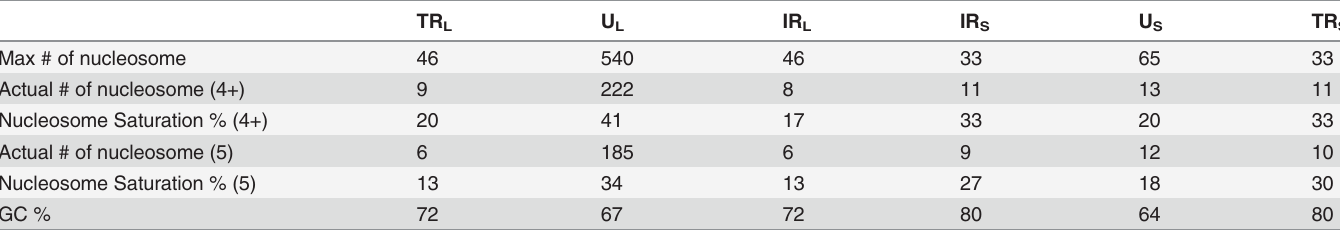
Table 1. Comparison of nucleosome distribution and GC content of regions of the HSV genome. TR